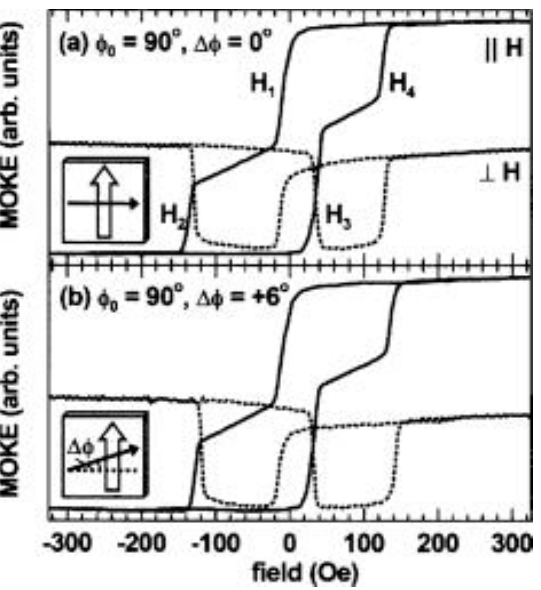
Figure 10. Magnetization reversal measured at low temperature at angles ( a ) perpendicular and ( b ) nearly perpendicular to the cooling field direction. Reprinted with permission from [111], Copyright 2005 AIP Publishing.